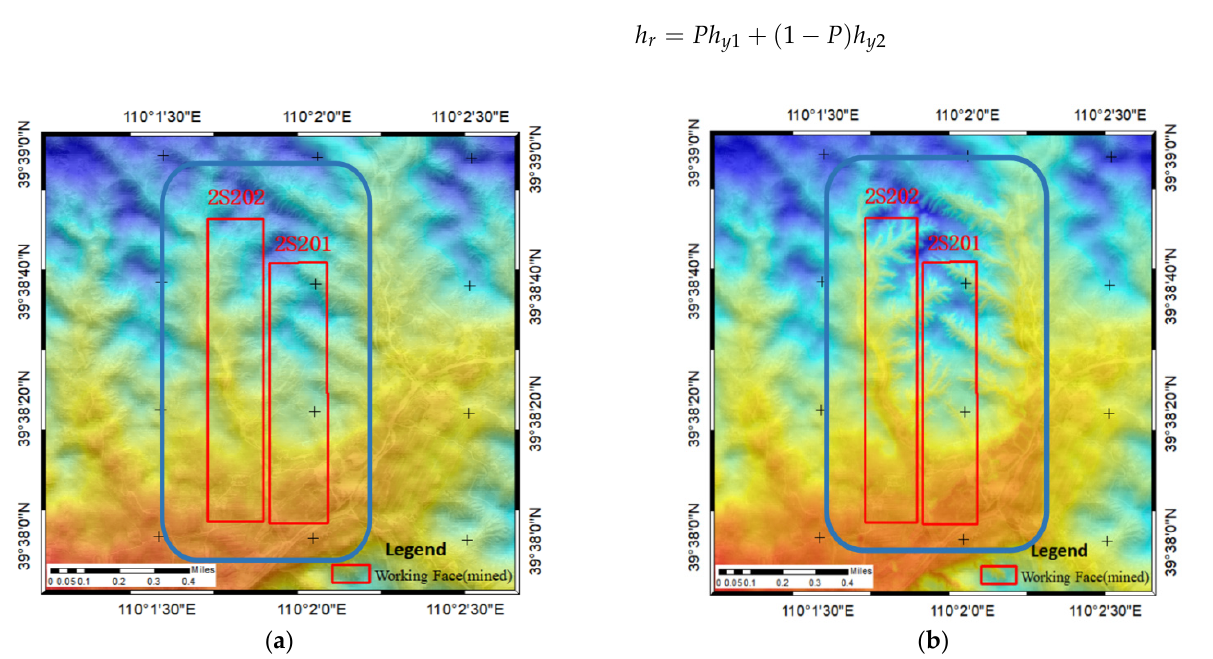
Figure 4. ( a ) ALOS DEM; ( b ) Fused DEM; 2S201 and 2S202 are working faces, the data is of produc-